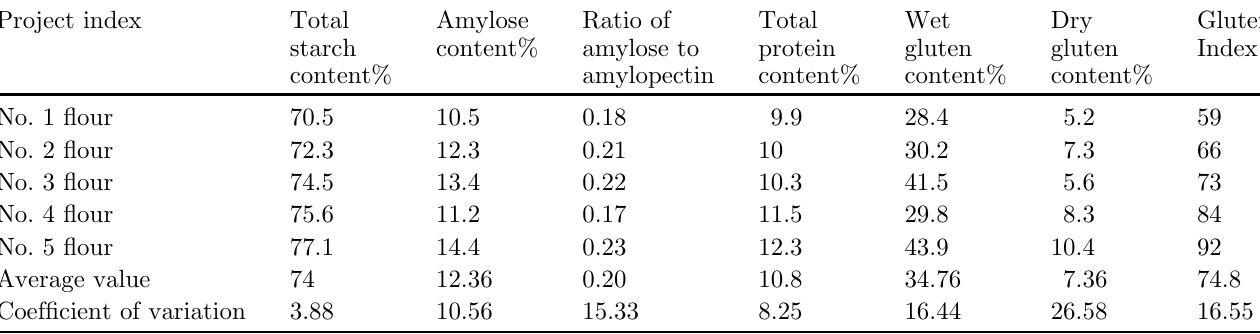
Table 1. Quality index analysis of starch and protein in wheat fl our. Project index